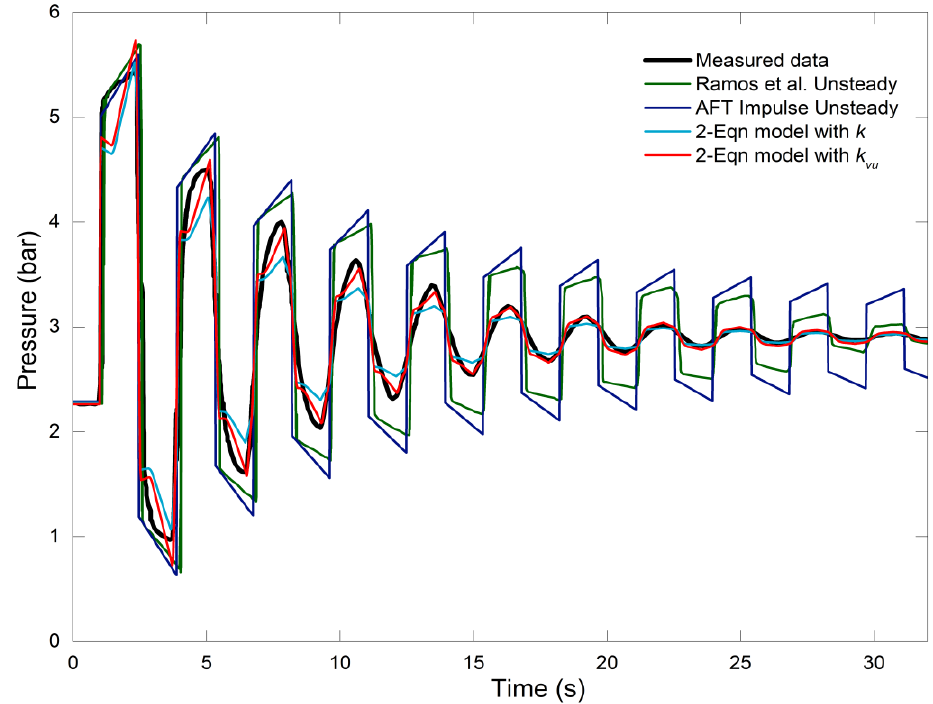
Figure 4. Transient pressure for Mitosek's experiment on HDPE pipe predicted by different